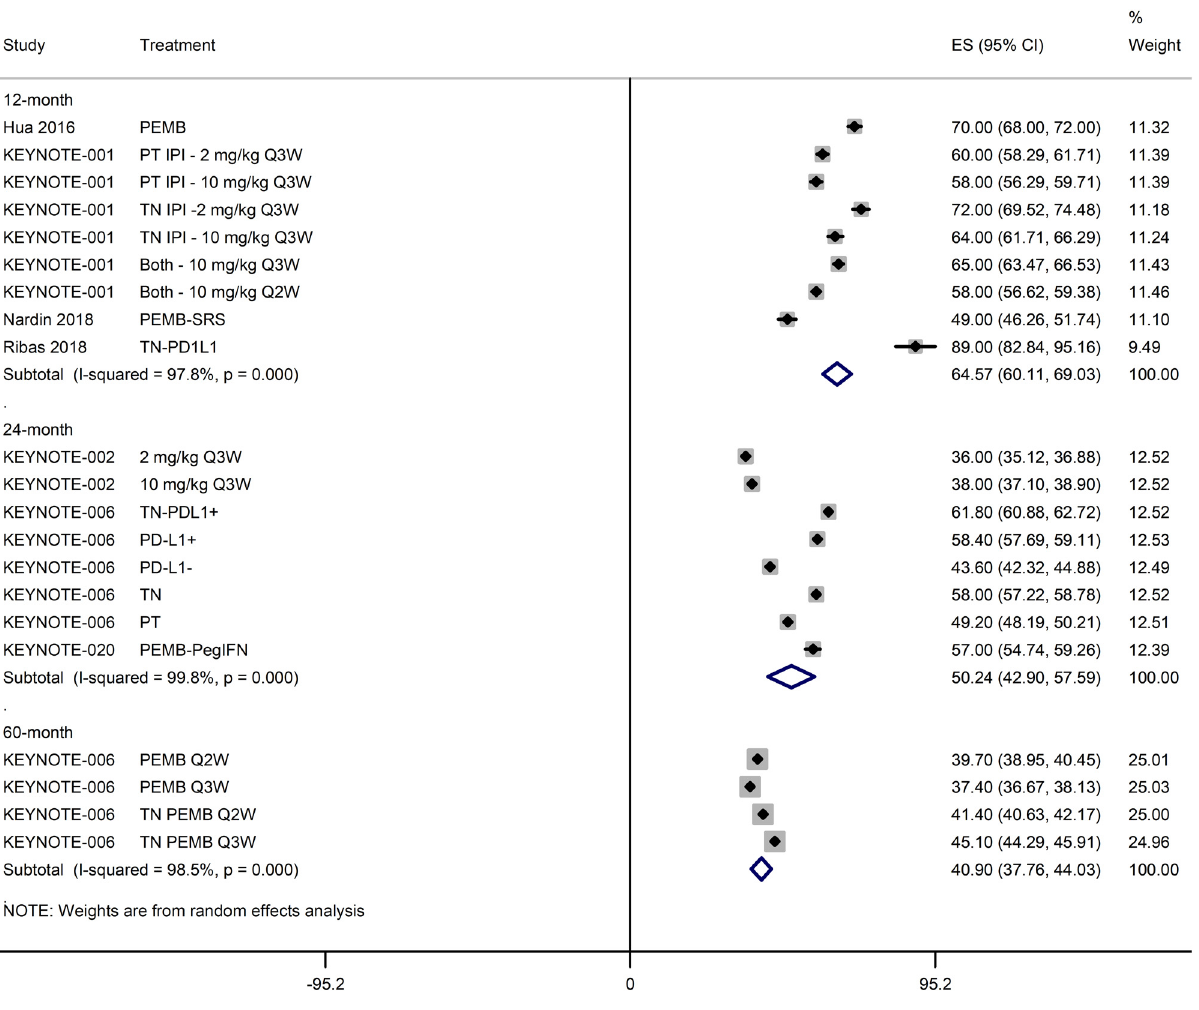
Figure 5: A forest graph showing the pooled 12 - , 24 - , and 60 - month OS ( ES; e ff ect size with 95% CI )